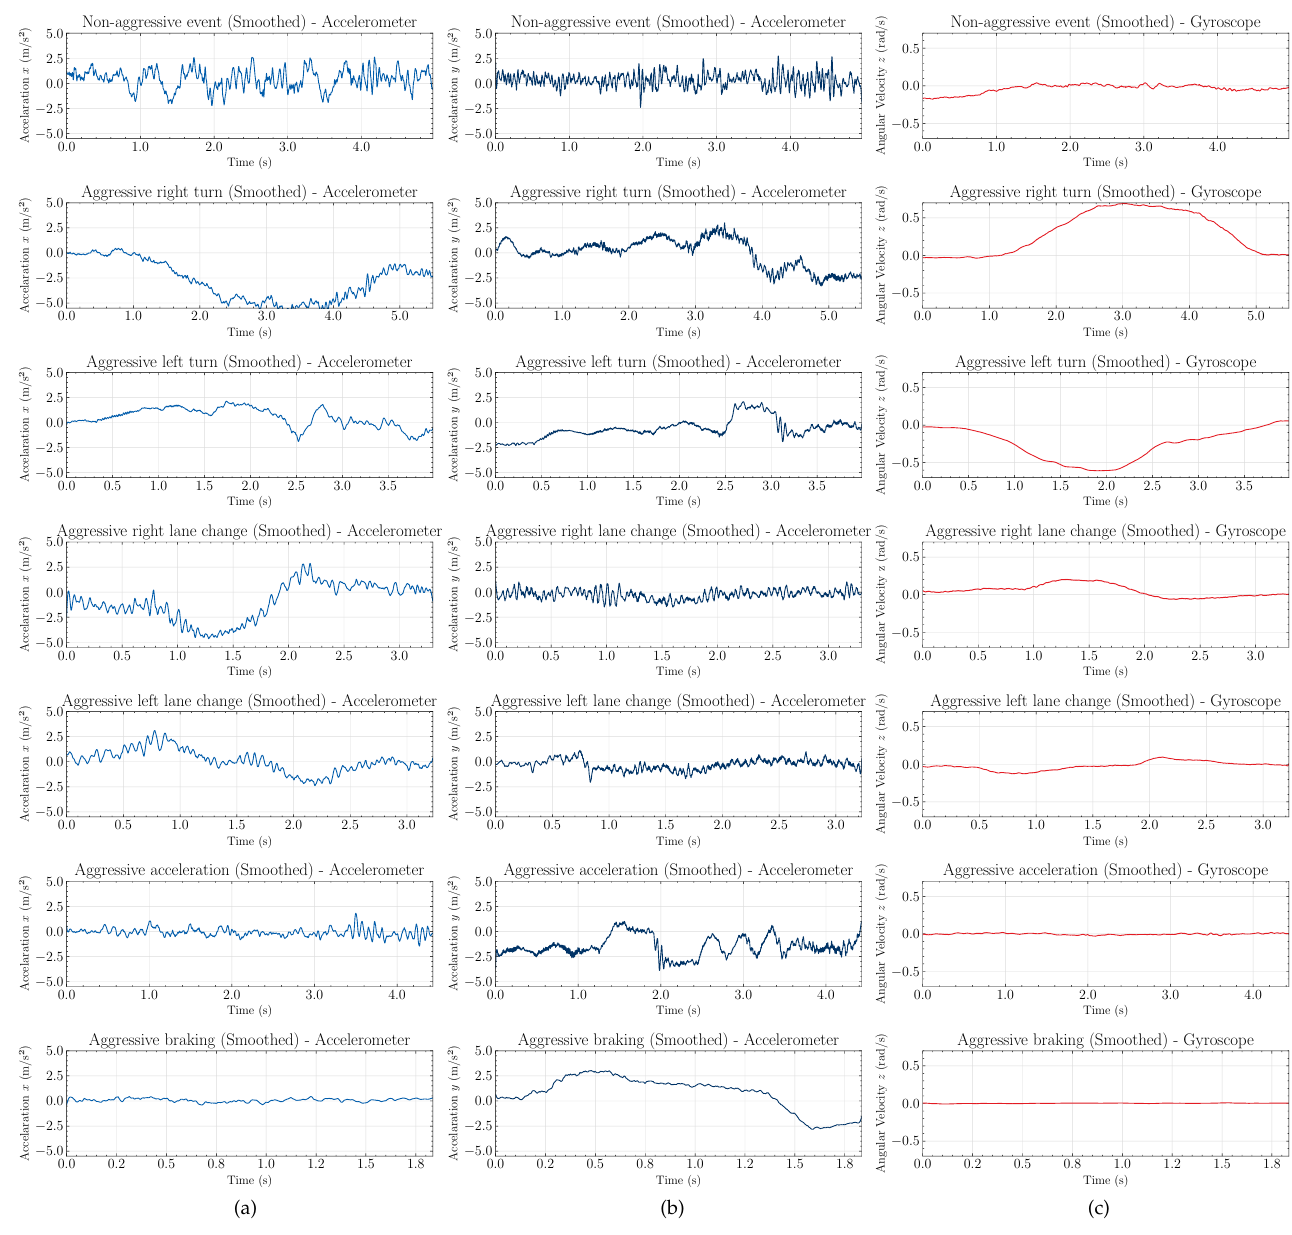
Figure 5. Smoothed data of linear acceleration in the x direction, first column ( a ), y direction, second column ( b ), and angular velocity in the z direction, third column ( c ), for non-aggressive events (first row), aggressive right and left turn (second and third rows), aggressive left and right lane changing (fourth and fifth rows), aggressive braking (sixth row), and aggressive acceleration (seventh row),